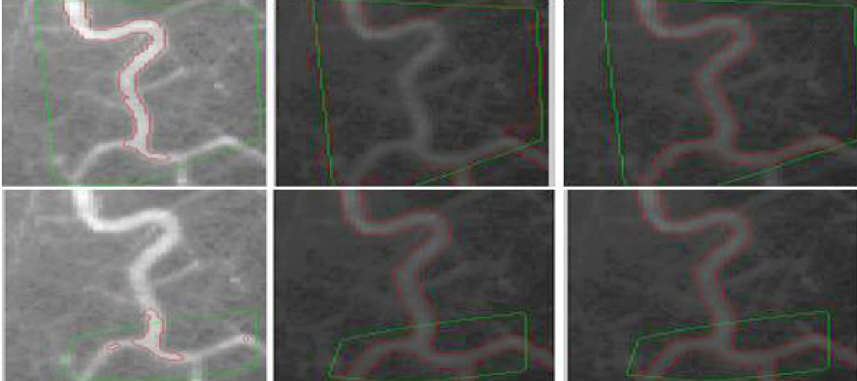
FIG. 5. SEGMENTATION EFFICIENCY OF THREE METHODS AGAINST TWO DIFFERENT INITIALIZATIONS ON SYNTHETIC VASCULAR IMAGE (LEFT) LOCALIZATION METHOD (MIDDLE) YIN’S METHOD (RIGHT) PROPOSED METHOD, GREEN IS INITIALIZATION AND RED IS FINAL